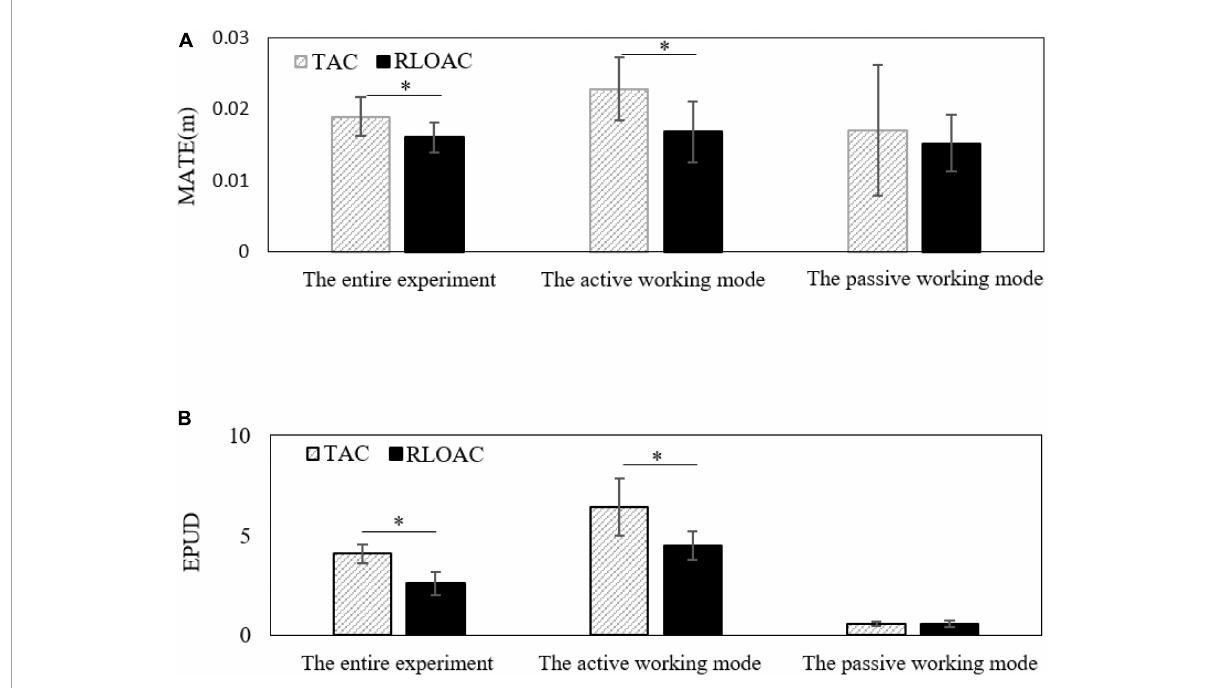
FIGURE9 Comparison of human–robot interaction (HRI) performance in term of the mean absolute tracking error (MATE) (A) and energy per unit distance (EPUD) (B) between the proposed reinforcement-learning-based optimal admittance control (RLOAC) and traditional admittance control (TAC) in the entire experiment, the active working mode, and the passive working mode, respectively. Each plot shows the mean value for the subjects when TAC was used (grid) and when the proposed RLOAC was used (black). The error bars indicate the standard deviation, and the asterisk “ ∗ ” indicates p <